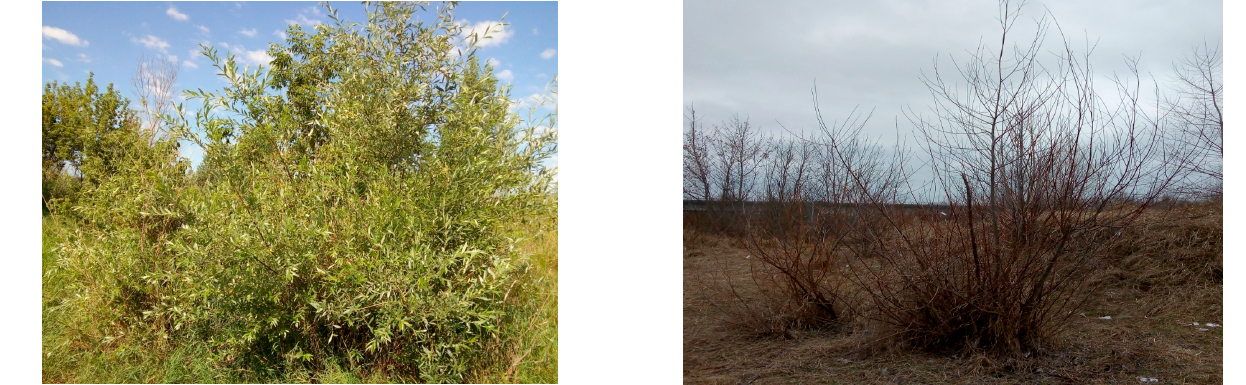
Figure 2. View of shrub 1 during the vegetation conditions (( left photo )—14 July 2020) and the non-vegetation conditions (( right photo )—13 December 2020).